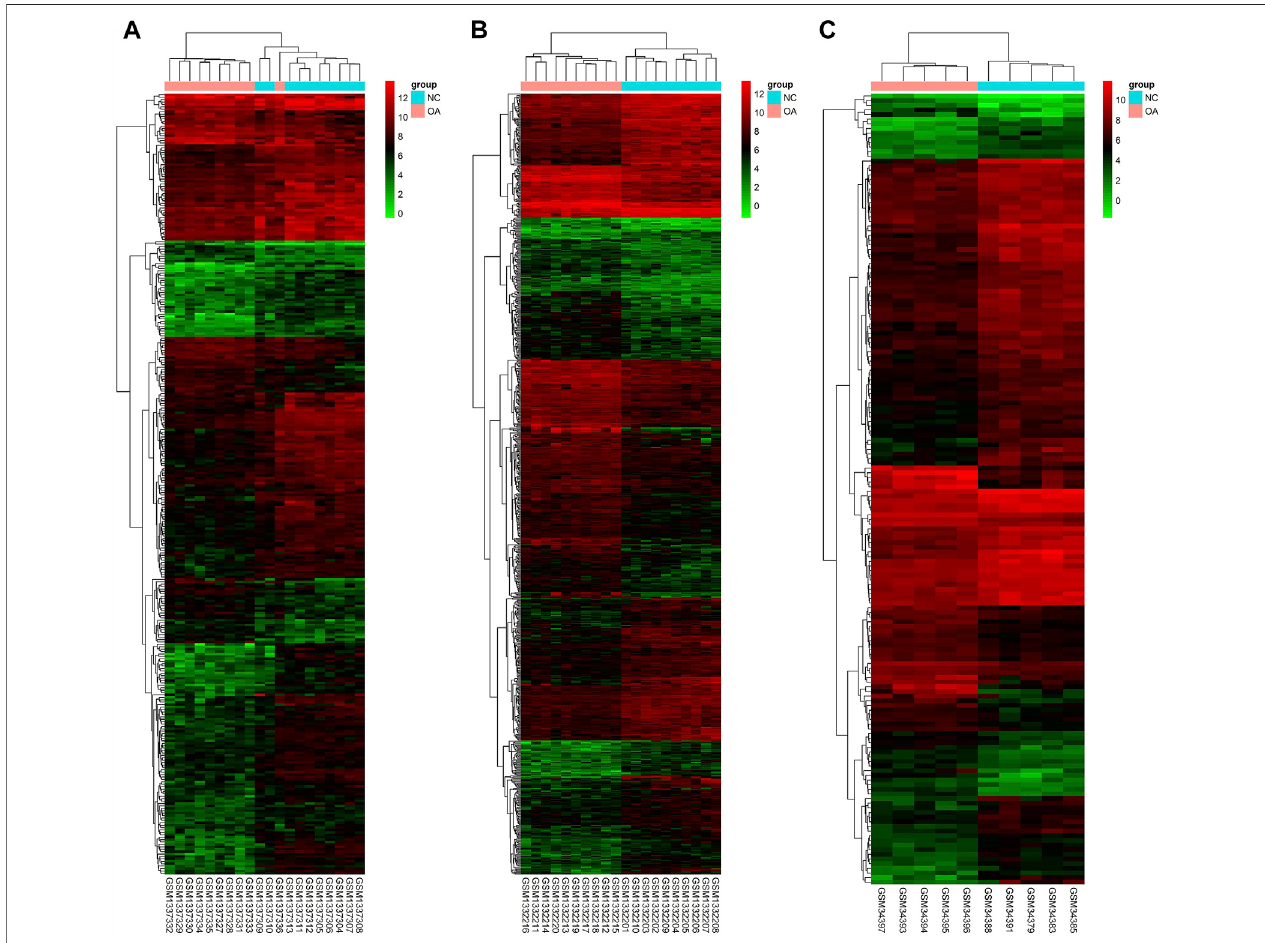
FIGURE 3 | Heatmap showing DEGs. (A) GSE55457, (B) GSE55235, and (C) GSE1919. The expression values are log2 fold changes ( > 1 or < − 1). Red color represents upregulation, and blue color represents